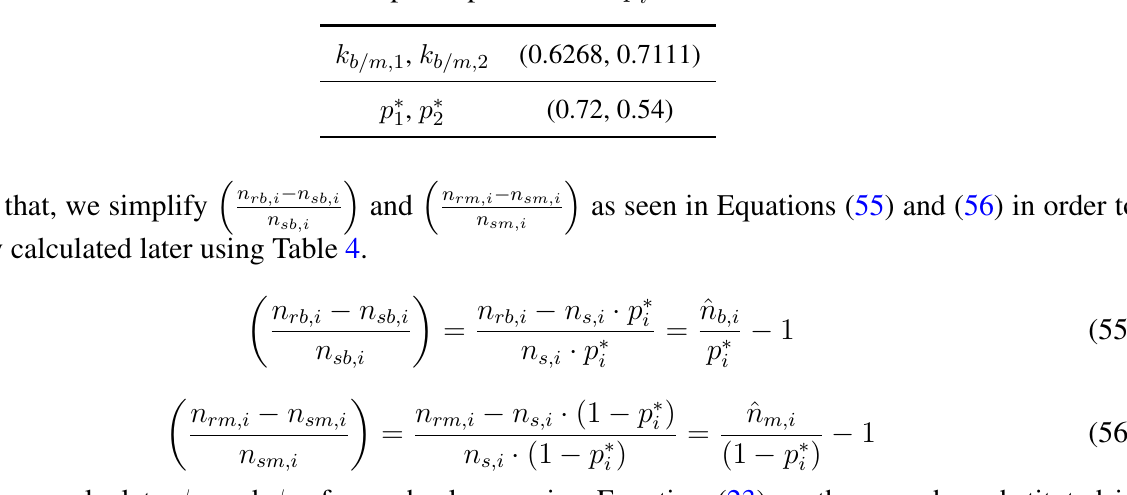
Table 5. Best response probabilities p ∗